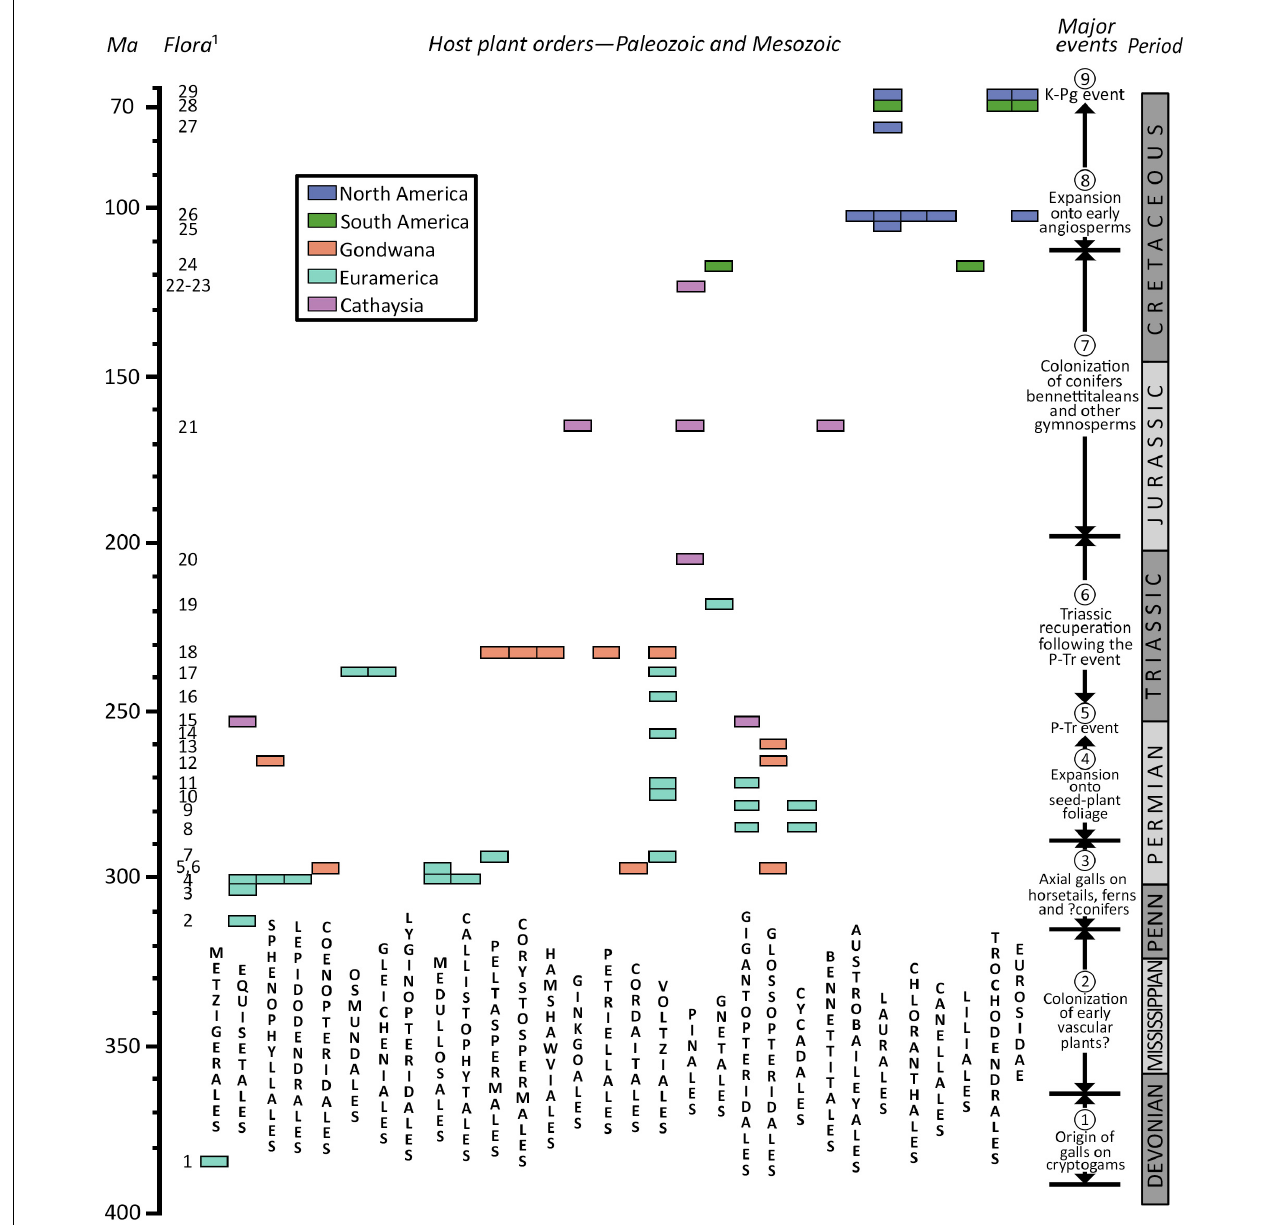
FIGURE 2 | Biogeographic distribution and major events affecting gall-bearing, host-plant orders through the Paleozoic and Mesozoic eras. See Supplementary Appendices 1, 2 for documentation for flora numbers at left. Time scale after Walker et al. (2018).